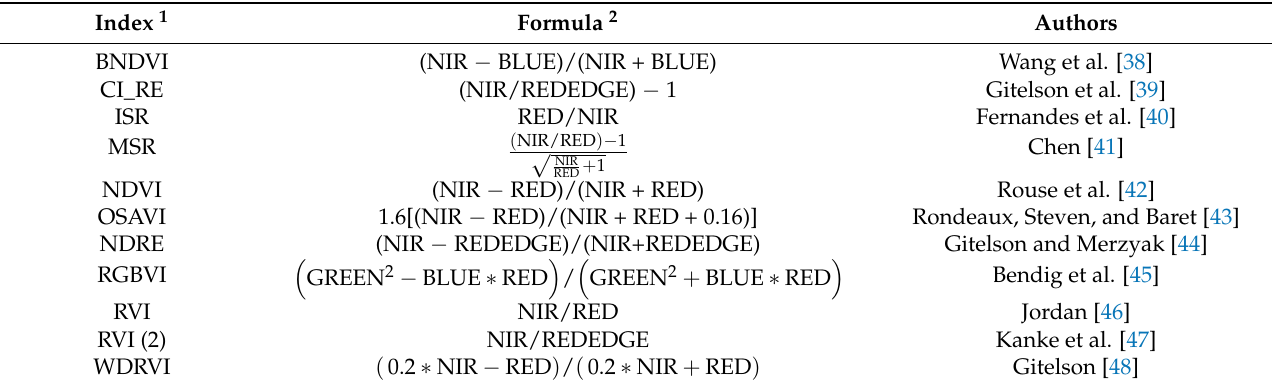
Table 3. Vegetation indices used in the